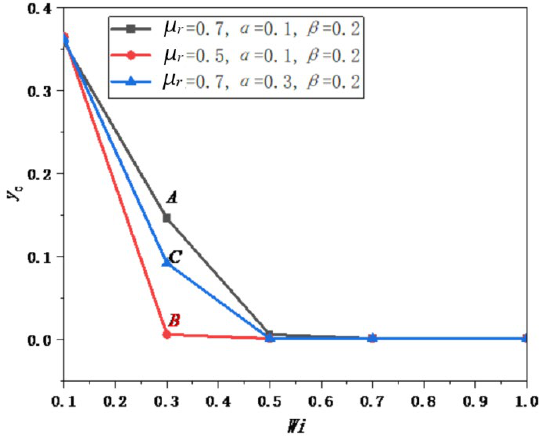
Figure 8. y c as a function of Wi for different values of µ r and α ( β = 0.2).